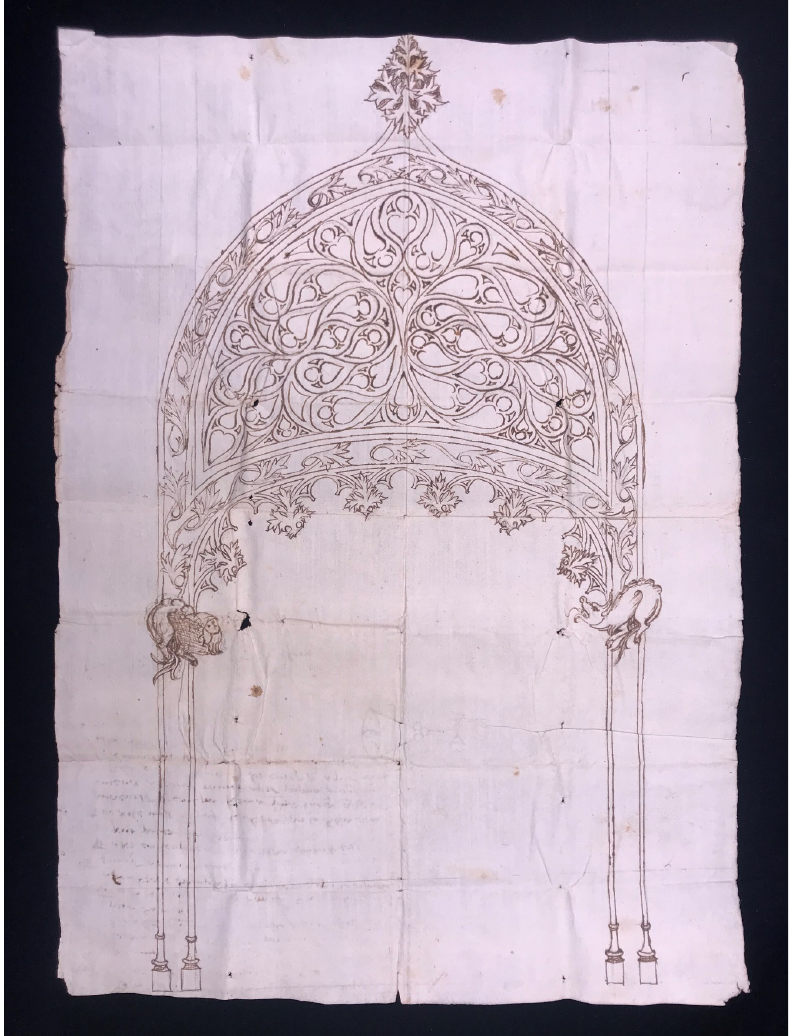
Figure 4. Project for the portal of the chapel of Saints Cosmas and Damian in the parish church of Santiago in Zaragoza [Archivo Hist ó rico de Protocolos Notariales de Zaragoza (A.H.P.N.Z.), Fondo de muestras y trazas]. © Archivo Hist ó rico de Protocolos Notariales de